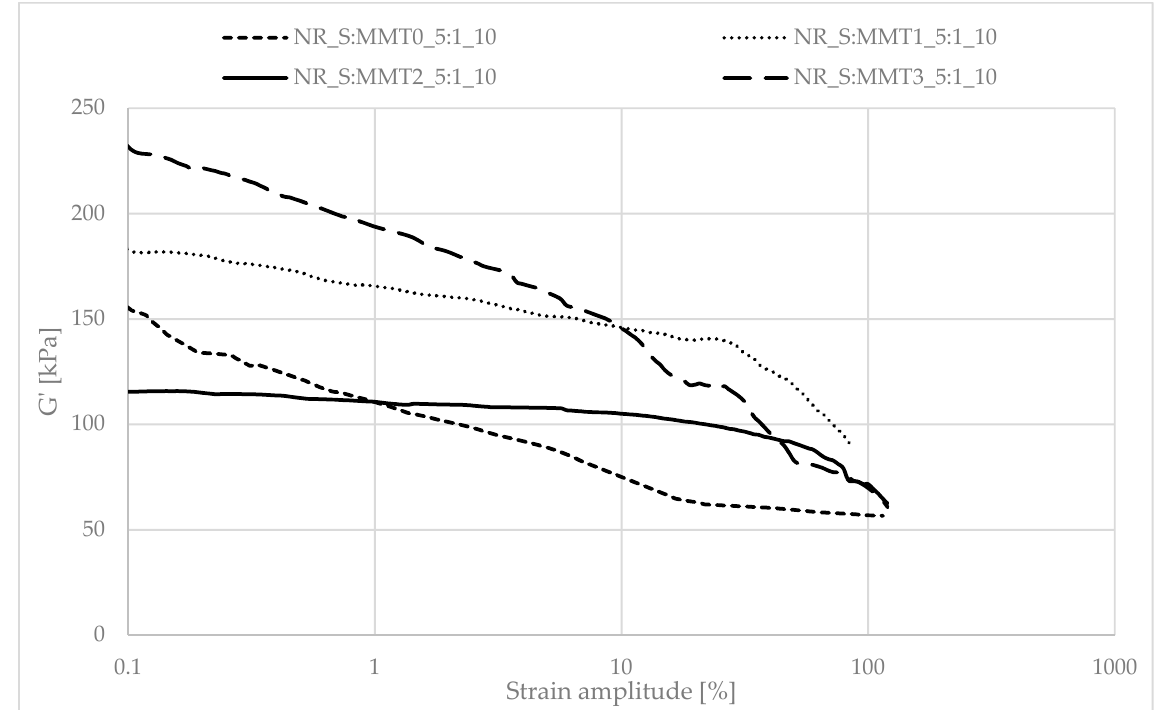
Figure 8. Dependence of the storage module as a function of the strain amplitude for natural rubber composites filled with straw:montmorillonite filler (10 phr), 5:1 ratio.